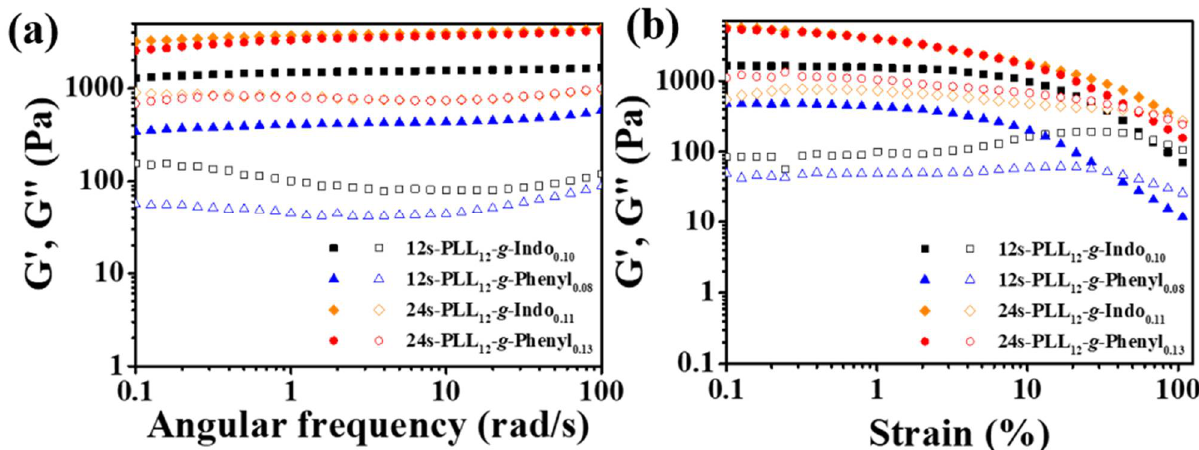
Figure 5. Storage modulus (G’: closed symbol) and loss modulus (G”: open symbol) of ( a ) 12-armed and 24-armed graft polypeptide hydrogels under different angular frequencies at fixed strain (0.1%) and ( b ) various strains at an angular frequency of 1.0 rad/s. The polypeptide concentration of all samples was 8.0 wt%.